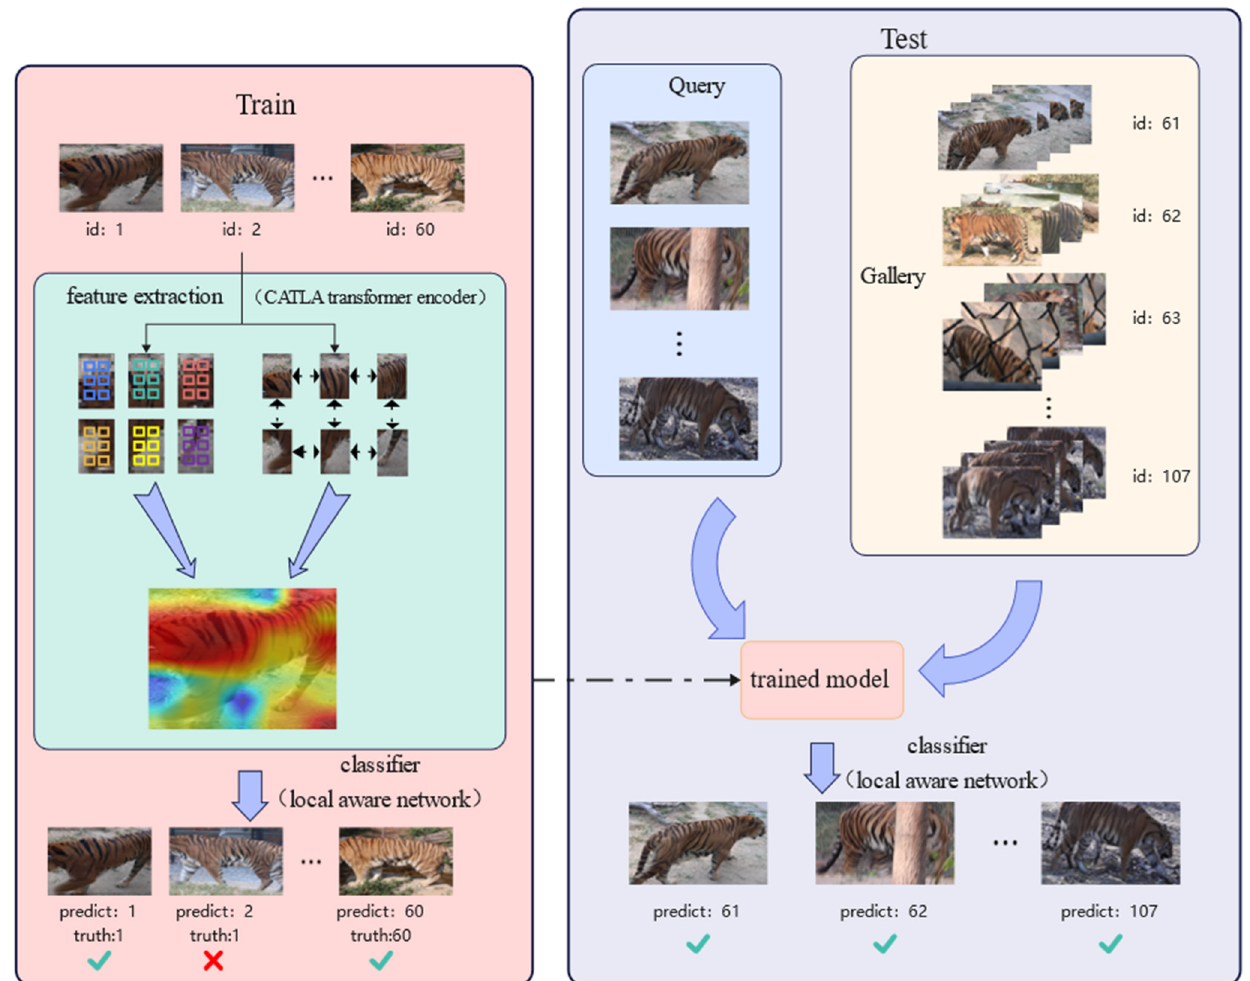
Figure 2. Workflow of the wildlife